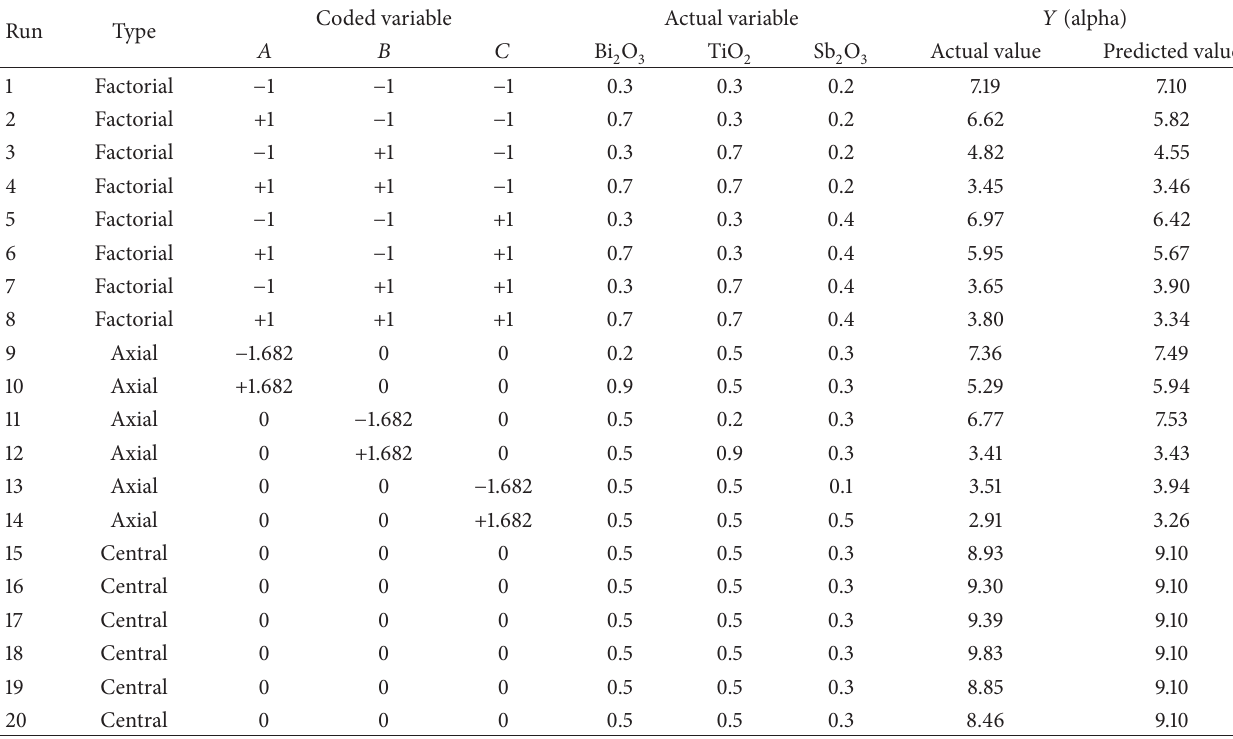
Table 2: The five-level experimental design of the three additives, Bi low-voltage varistor. The data was presented by coded and actual values.